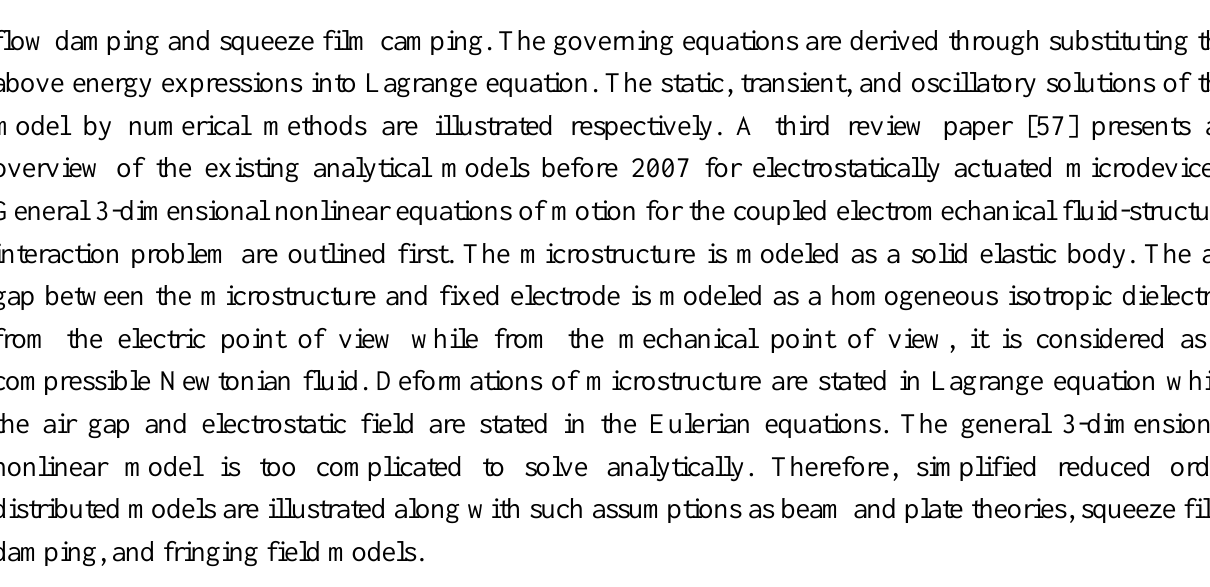
Figure 1. Nonlinear electromechanical coupling systems.